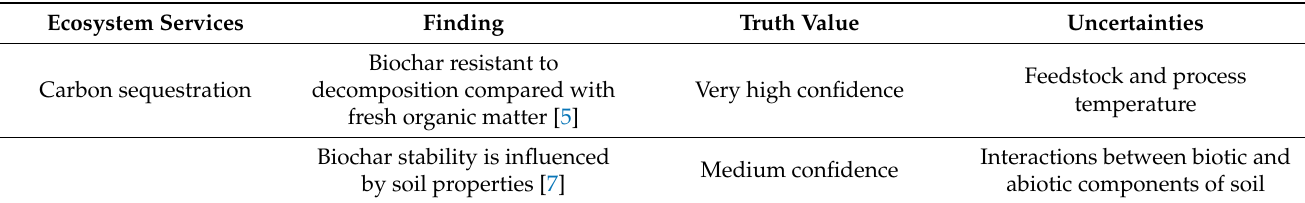
Table 1. Ecosystem services affected by biochar, associated with findings and uncertainties. Ecosystem